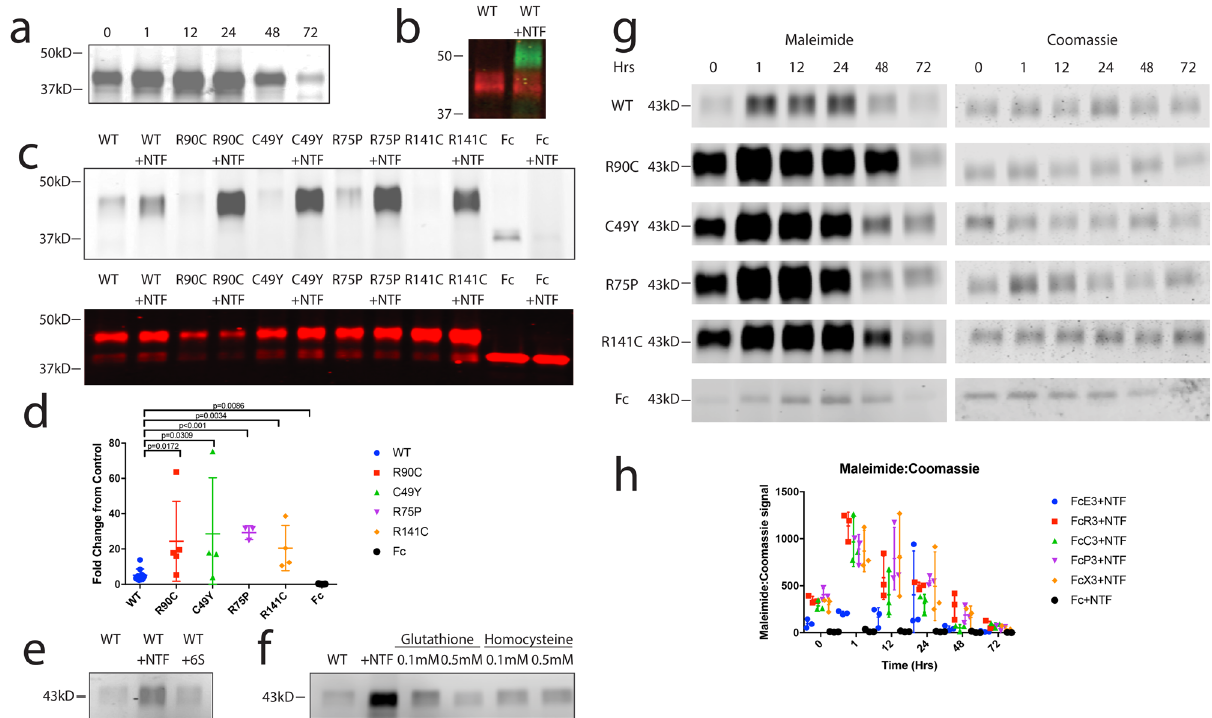
Fig. 4 NTF releases cysteines in NOTCH3 and makes them accessible for thiol-labeling. Following the addition of NTF to Fc-tagged NOTCH3 containing the fi rst 3 EGF-like repeats, we observed increased maleimide signal with increased lengths of incubation with NTF until 24 h, after which signal decreased ( a ). Detection of NTF using an antibody speci fi c for the cleaved fragment of NOTCH3, UMI-D, revealed a complex at a size larger than the NOTCH3 alone size ( b ; green). Puri fi ed NOTCH3 was identi fi ed by probing for the Fc tag ( b ; red). We observed increased maleimide signal with the addition of NTF to all WT and mutant samples, while the addition of NTF to Fc protein alone did not increase signal ( c , upper panel). A parallel set of samples was transferred to nitrocellulose using the iBlot 2 system and protein loading amounts were veri fi ed by probing for Fc ( c , lower panel). Quanti fi cation of maleimide signal in samples with and without NTF demonstrated 5.13-fold enhancement in WT protein and 24.37-fold, 28.55-fold, 29.26-fold, and 20.44-fold enhancement in mutant proteins R90C, C49Y, R75P, and R141C, respectively ( d ). The addition of NTF to Fc resulted in 20% signal compared to without NTF ( d ). Effects of NTF on puri fi ed WT NOTCH3 were compared to those from a form of NTF with all cysteines mutated to serine (6S). The addition of NTF to NOTCH3 resulted in an increased maleimide signal, while no increase was observed with the addition of 6S to NTF ( e ). Similarly, no increase was observed with the addition of two concentrations (0.1 and 0.5 mM) of two other sulfhydryl-containing compounds, glutathione and homocysteine ( f ). NTF was then added to puri fi ed Fc-tagged NOTCH ectodomain fragments for increasing lengths of time. Cysteines were then capped with 10 μ M IRDye 800CW Maleimide ( g , left panel). Total protein content was determined by SimplyBlue Safestain (ThermoFisher) ( g , right panel). Quanti fi cation of maleimide signal normalized to total protein amount revealed increasing maleimide signal that peaks at 1 h for all mutants and decreases with longer incubation times ( h ). WT protein signal peaks around 24 h. Experiments were repeated three times using distinct samples with similar results, and ( h ) plots the mean of three replicates. Unprocessed western blots can be found in Fig.